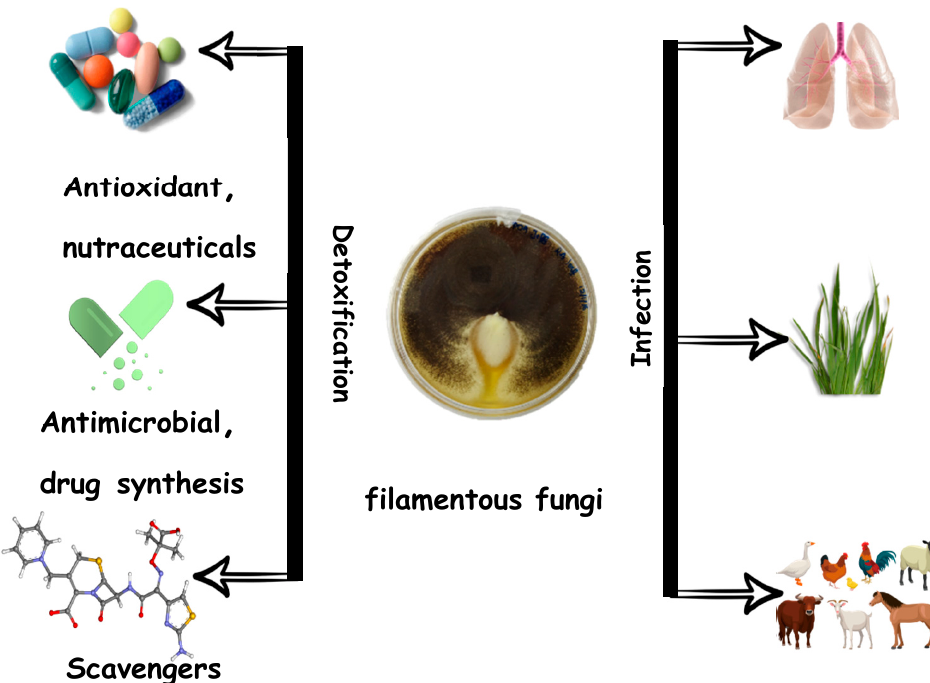
Figure 2. Pathogenic filamentous fungi potential and positive interactions with the human.